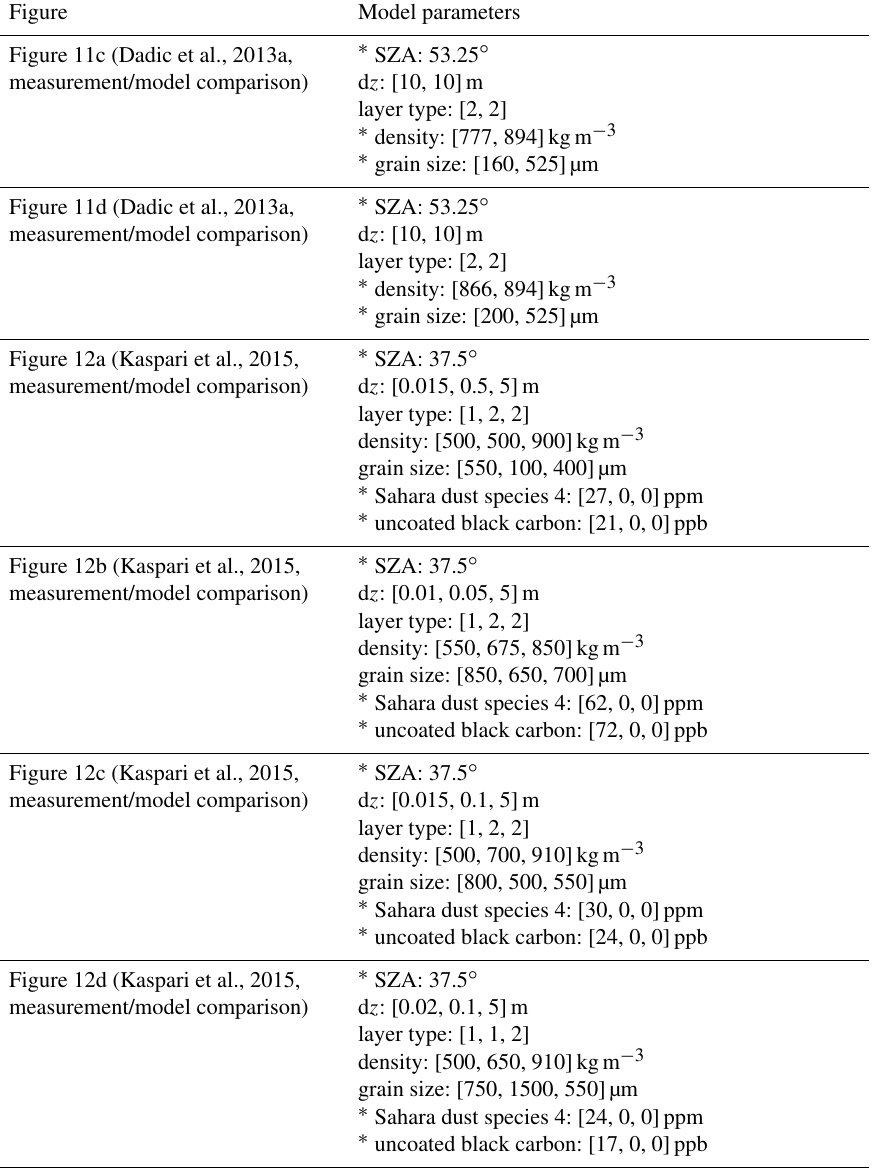
Figure Model parameters Figure 11c (Dadic et al., 2013a, measurement/model comparison)